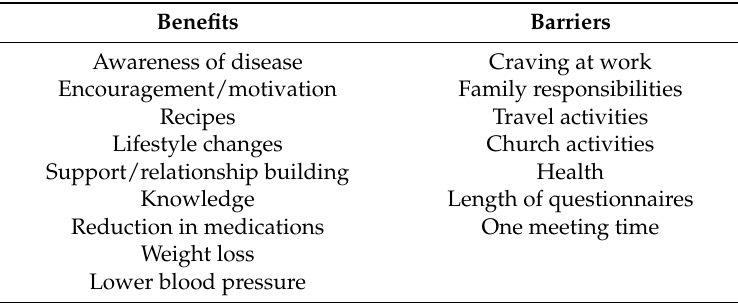
Table 4. Benefits and barriers themes from open-ended